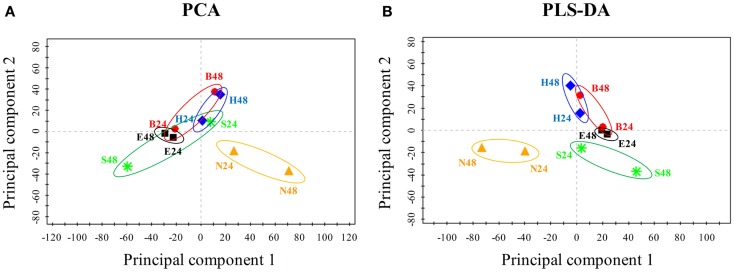
Principal component analysis and PLS-DA score plot of the responses under various stress conditions in Synechocystis. (A) PCA score plot. Samples with different treatments were indicated by colors. X-axis, Y -axis were labeled with the first principal component and the second principal component, accounting for 33.4 and 16.3% total variation, respectively. (B) PLS-DA score plot.